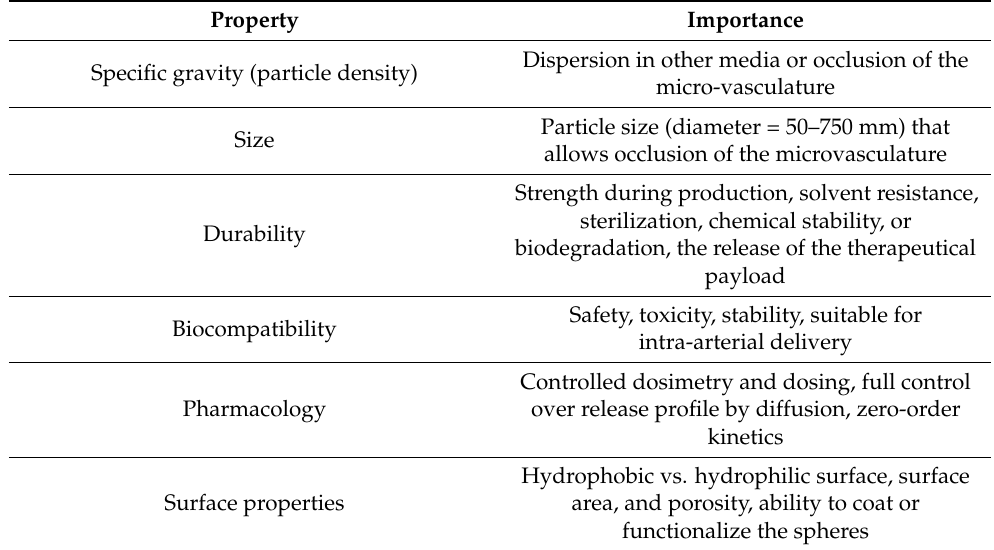
Table 1. Properties of microspheres: list of requirements for embolization (selected from: